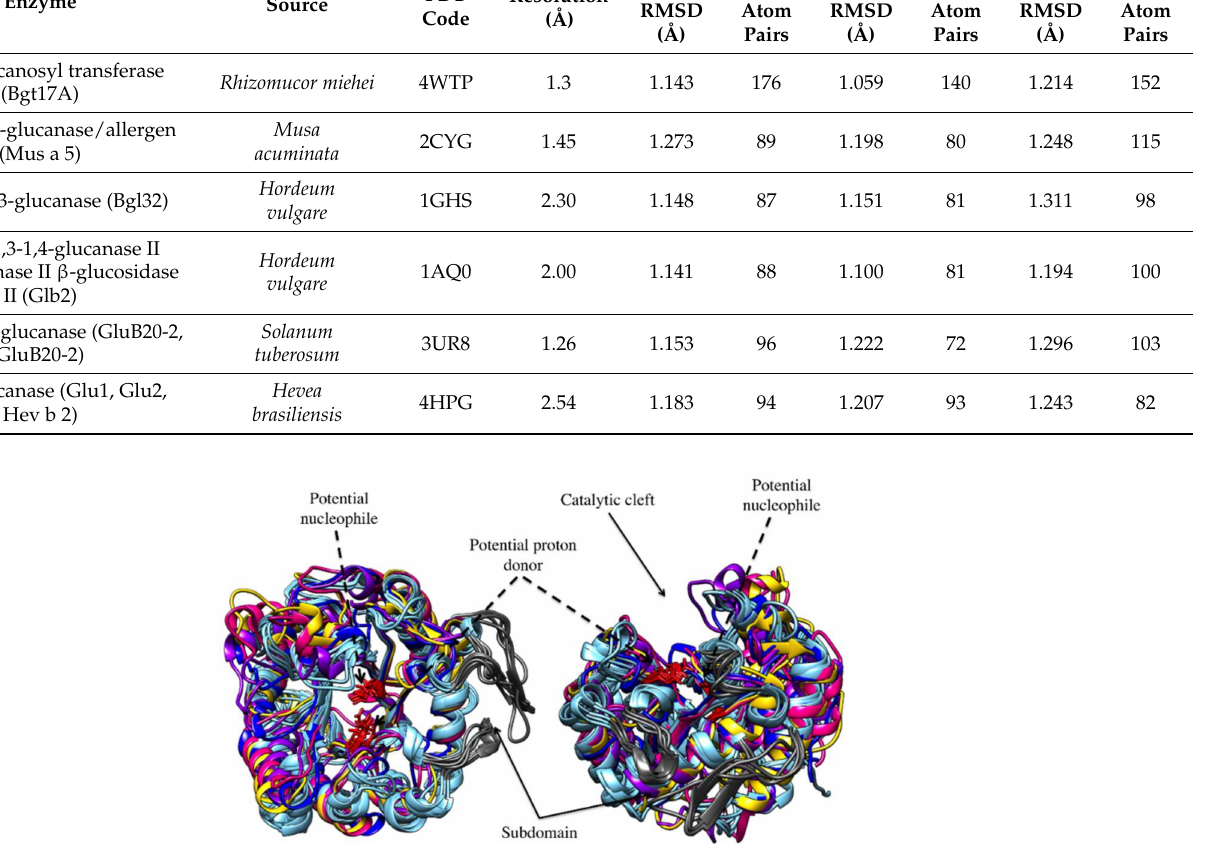
Figure 5. Superimposition of the modeled Glt-structures and crystallographic structures available in GH17 (see Table 3). Plant endo- β -glucanases are in cyan, GT RmBglt1A in dark blue, Glt1 in ping, Glt3 in yellow and Glt20 in purple. Additional subdomains in endo- β -glucanases are depicted in grey. Catalytic amino acids are represented as red